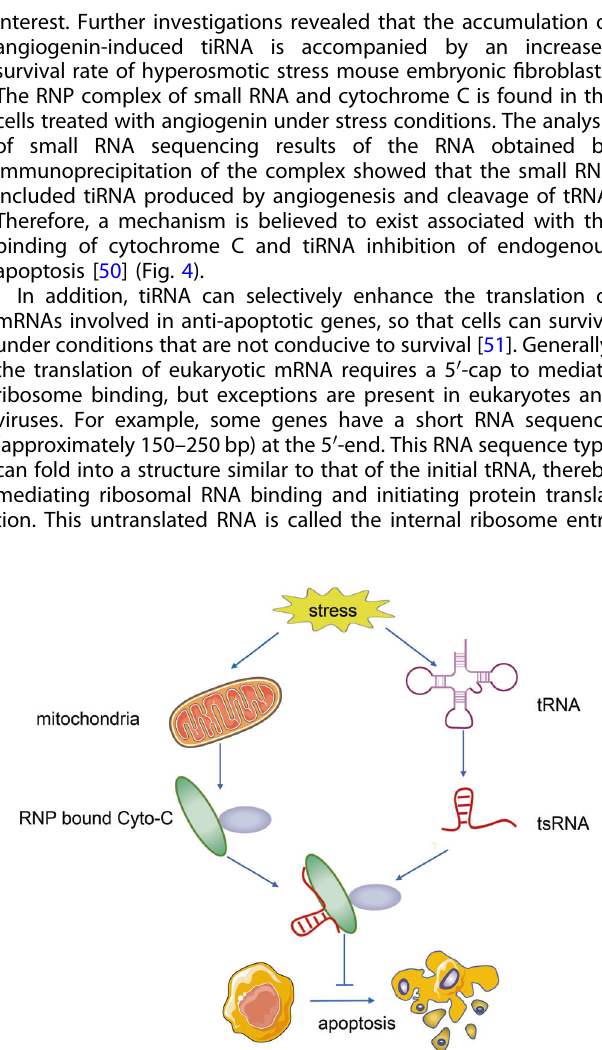
Fig. 4 The function of tsRNA on Cell apoptosis inhibition. Under stress condition, tsRNA bind to RNP with cytochrome C to form a complex result in inhibiting cell apoptosis.